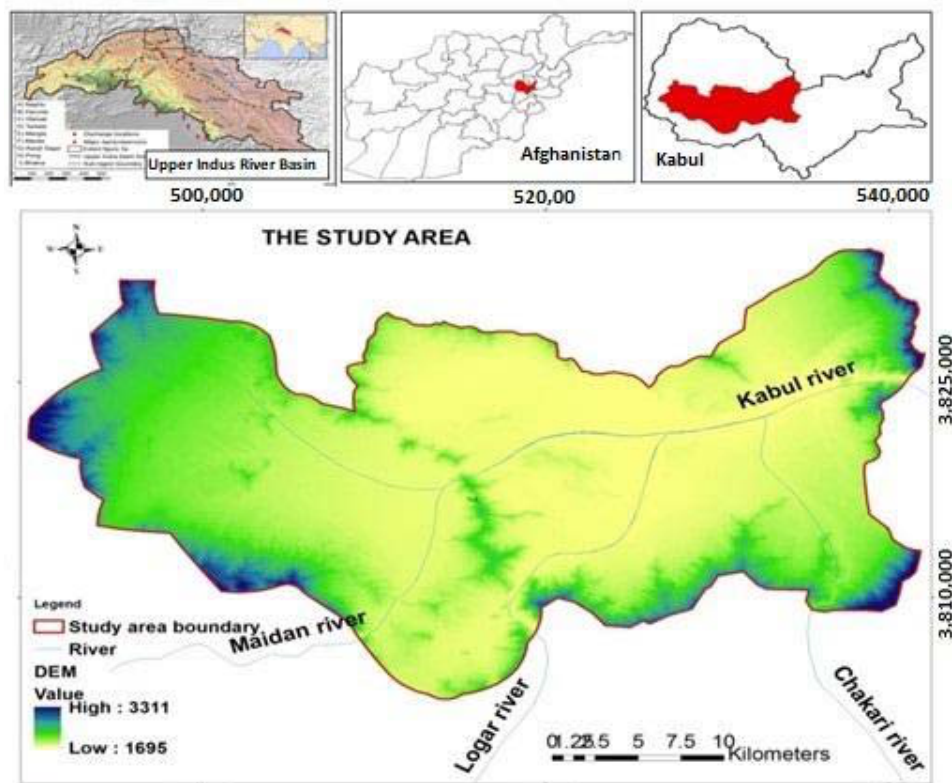
Figure 1. Location of the study area within the Upper Indus Basin.